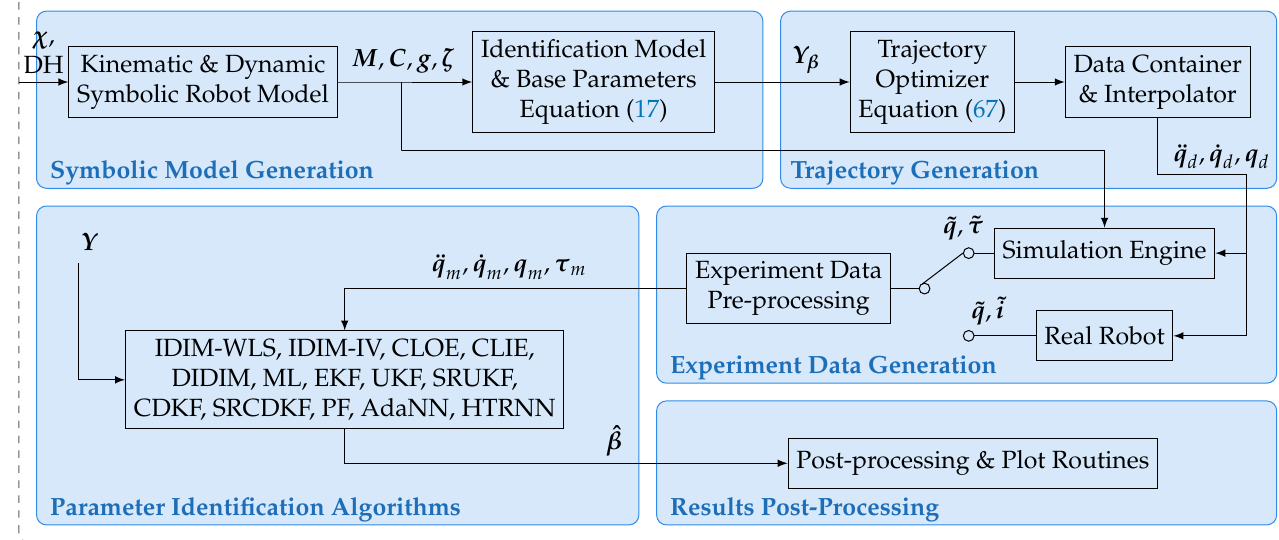
, ˙ q , q refers to d d d , ˙ q , q , τ m used for identification, m m m